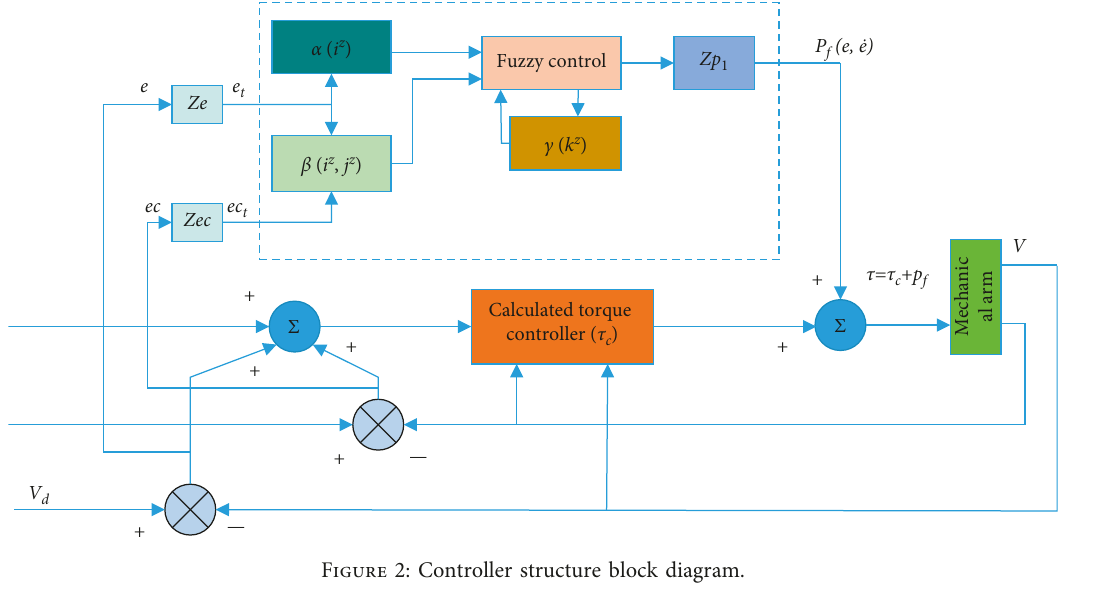
Figure 2: Controller structure block